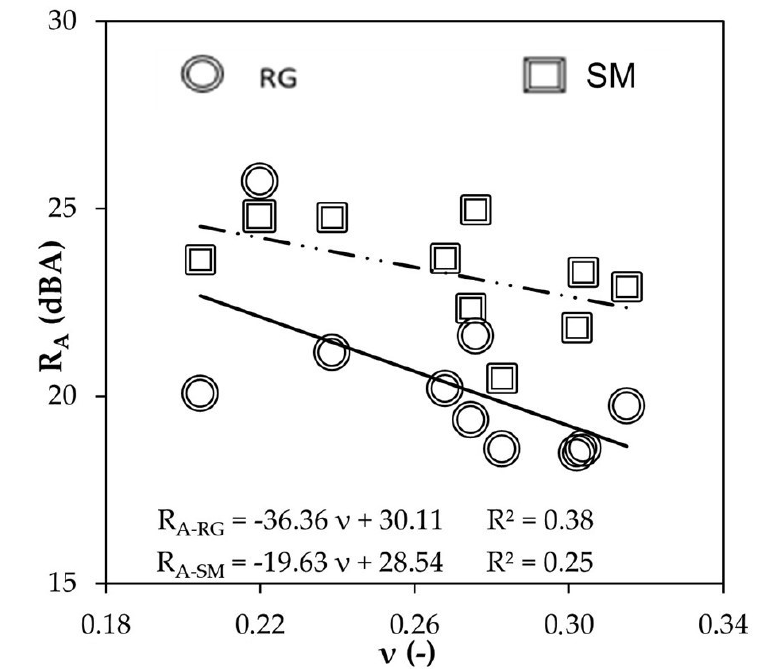
Figure 8. Experimental sound reduction index (R A ) versus Poisson’s ratio ( ν